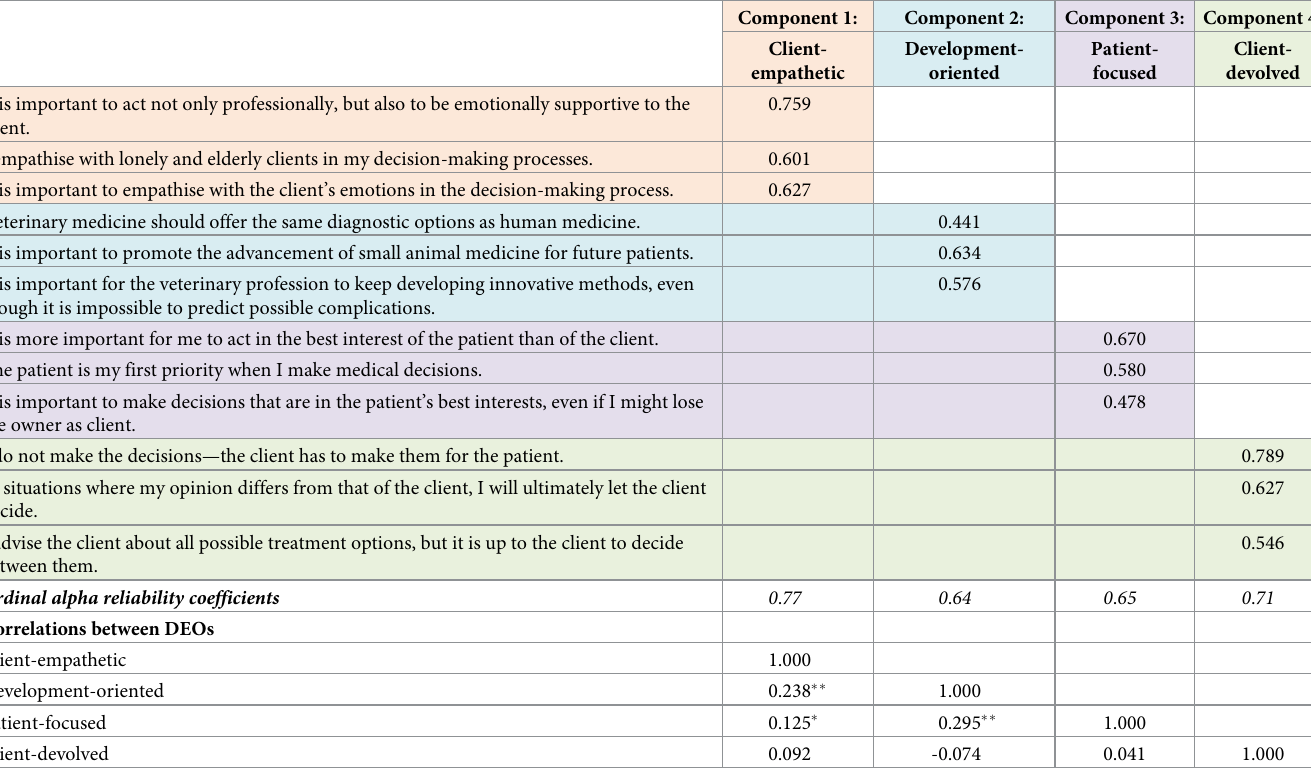
Table 3. Results from confirmatory factor analysis for the identification of veterinarians’ Decision Ethics Orientations (DEOs) (N =